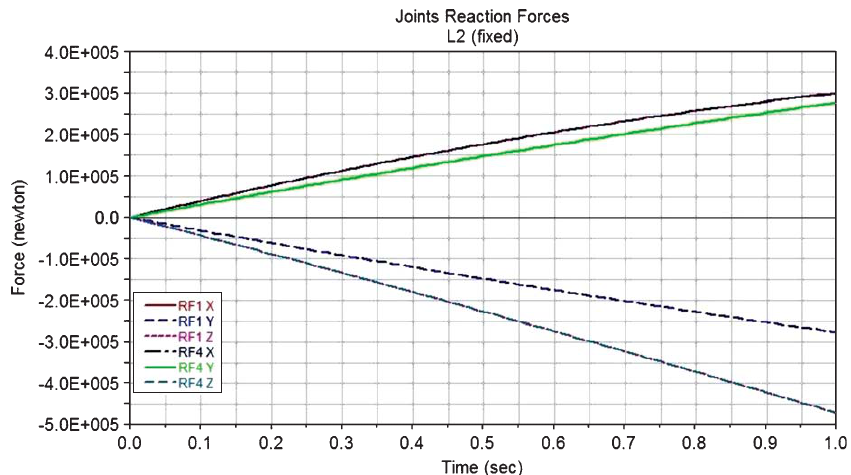
Fig. 14. Computed reaction forces at spherical joints that connects L2-A 1 , 1 and L2-A 1 , 4